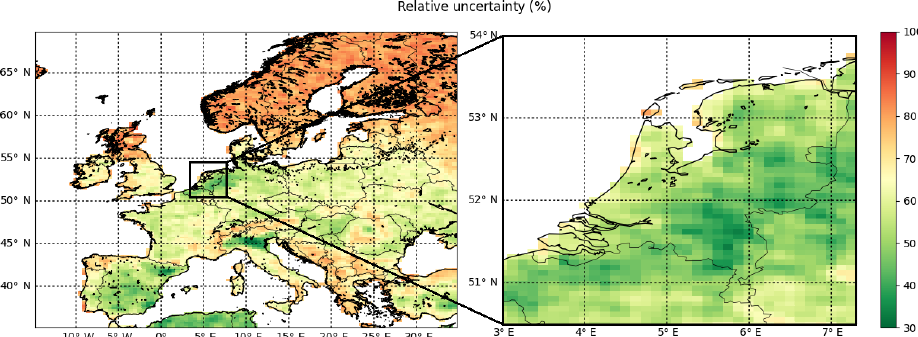
Figure 2. The relative error of the annual IASI-A retrieved NH 3 total column concentrations in Europe and the Netherlands in